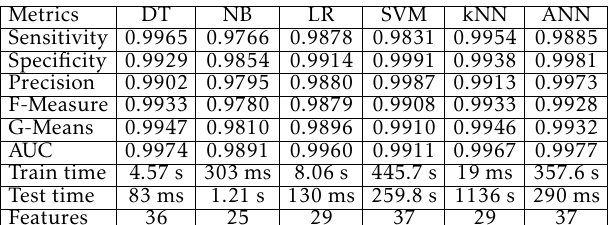
Table 36. Results of using GR-BFE algorithm on GENERIC. Metrics